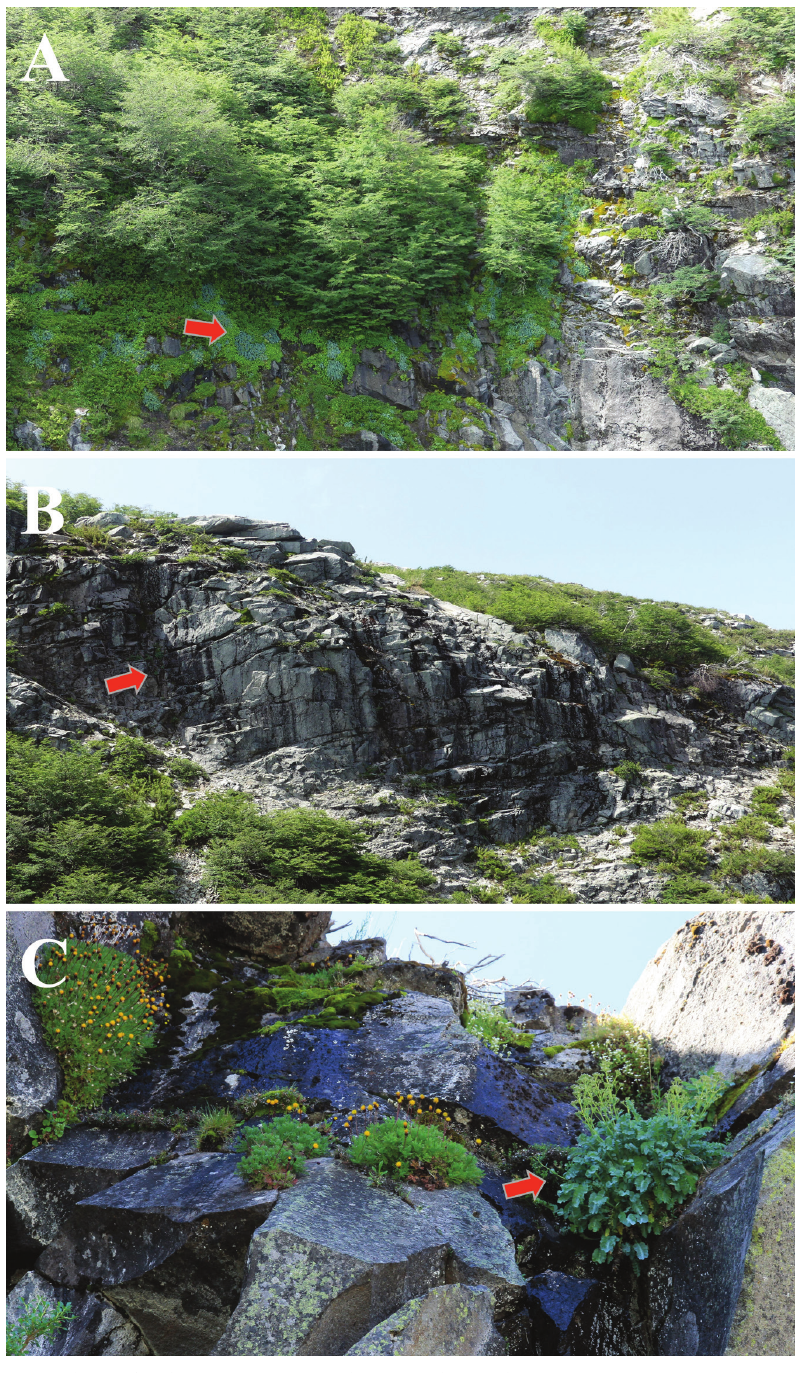
Figure 5. Habitat of Valeriana praecipitis (red arrow indicates the species) A, B L aguna Añil C Laguna del Florido. Photographed by Alejandro E. Villarroel and Kora